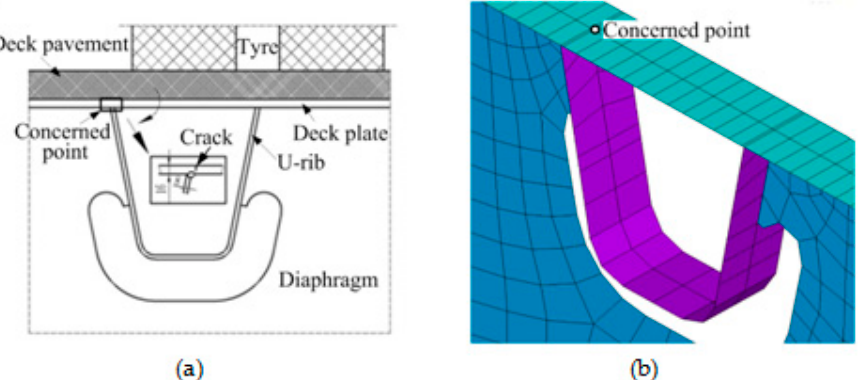
Figure 9. The position of the concerned point: ( a ) Position of the concerned point; and ( b ) the concerned point in the model.